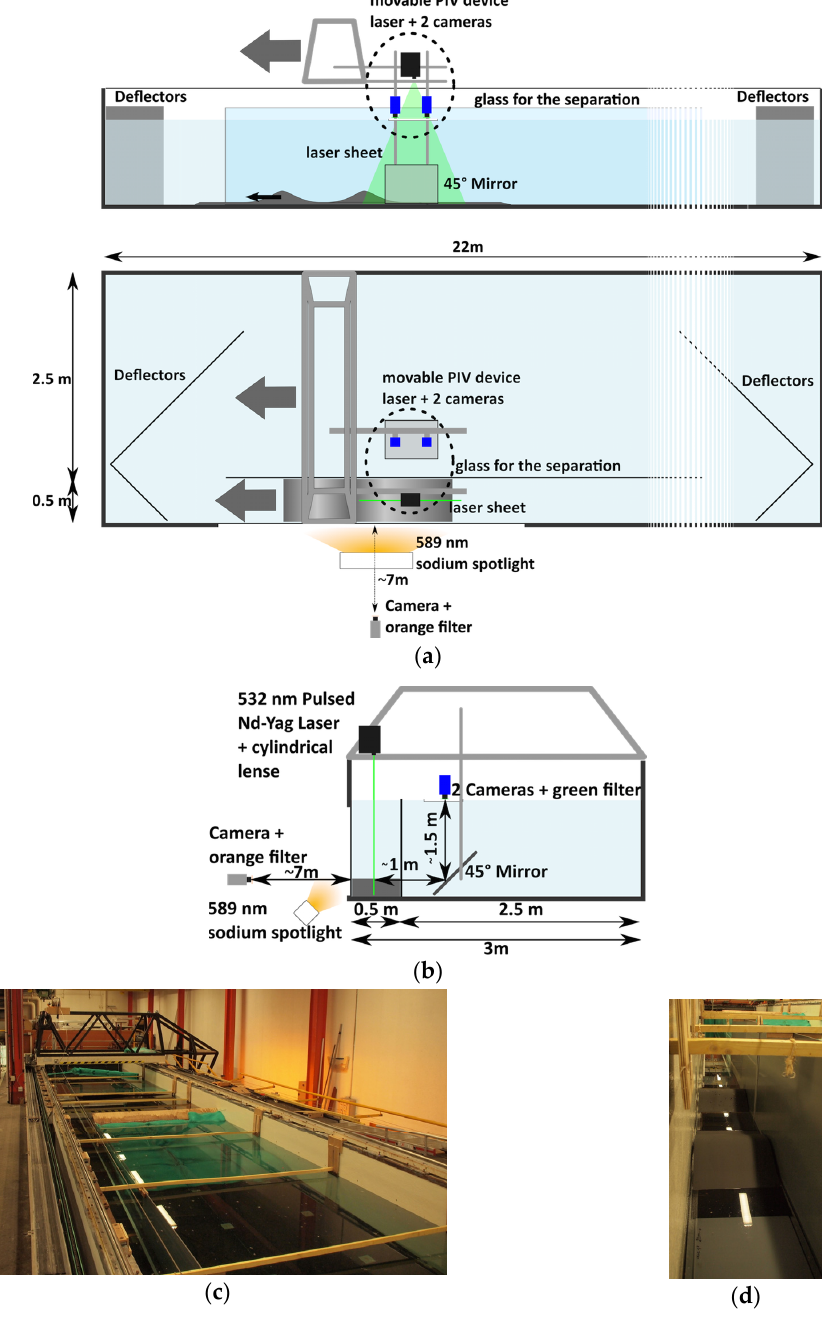
Figure 1. From top to bottom: ( a ) cross-section along the longer side of the water tank and the view from the top; ( b ) the cross-section along the shorter side of the CNRM large stratified water flume set-up used for the experiments; ( c ) photograph of the water tank; ( d ) photograph of the narrow part of the tank with the obstacles.